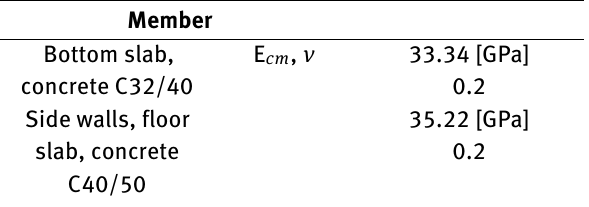
Figure 5: Location of nodes and beams and distribution of elastic constraints in cross section